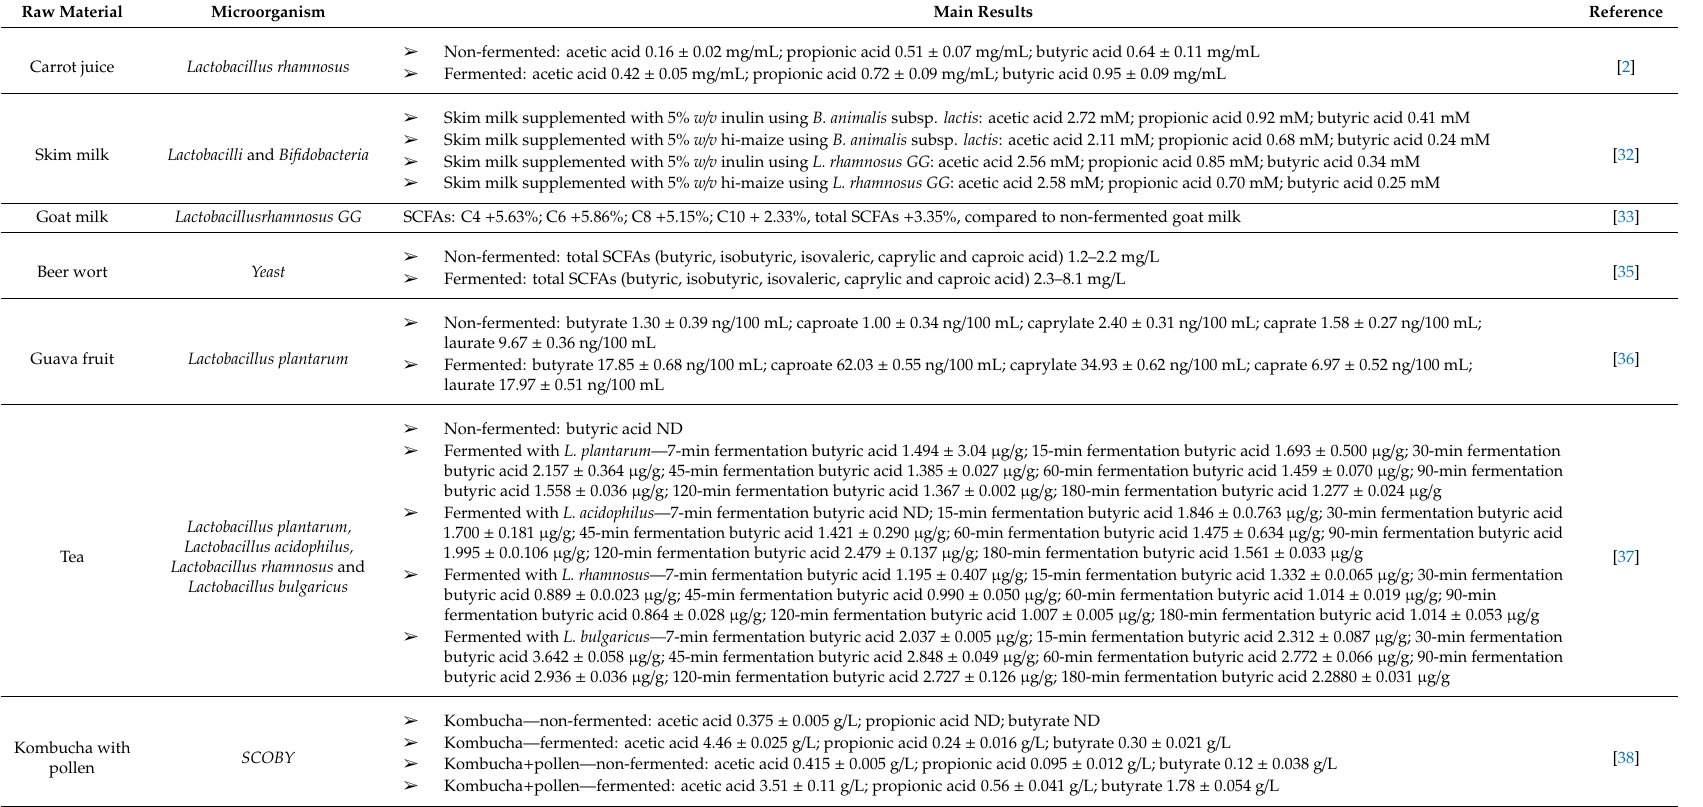
Table 1. Studies reporting the increased levels of short-chain fatty acids (SCFAs) in fermented